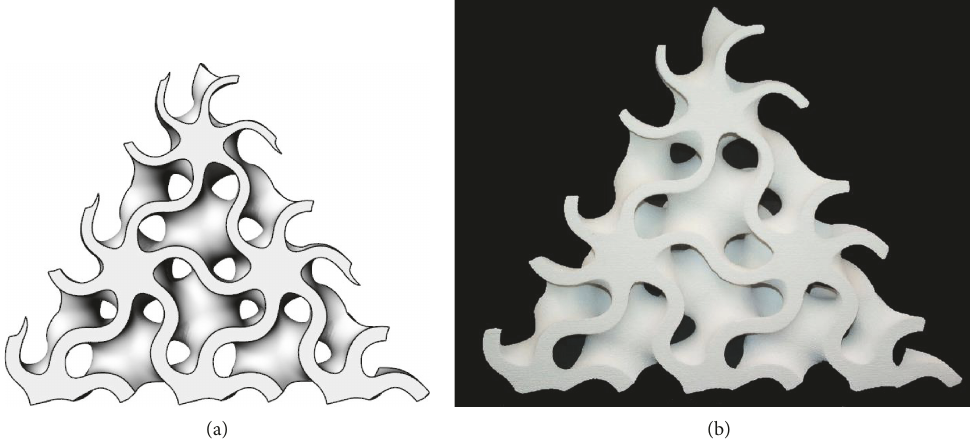
Figure 6: Oblique section of a variable thickness gyroid: (a) virtual and (b) physical model manufactured by additive manufacturing technology (ZPrinter 450 by 3D System).